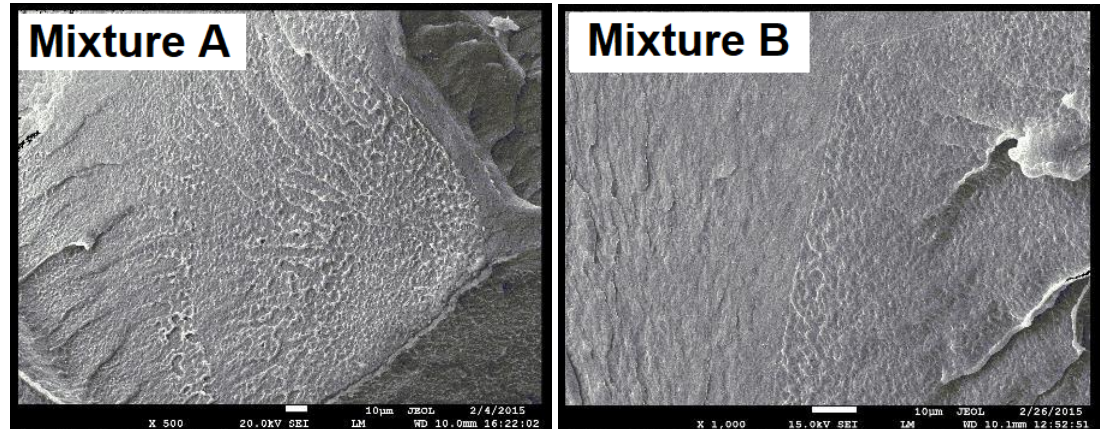
Figure 17. SEM—fracture surface structure of Mixtures A and